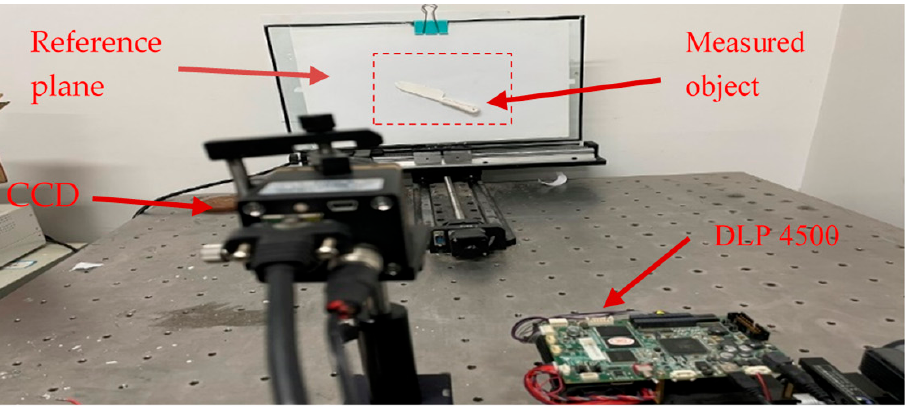
Figure 8. Schematic of experimental